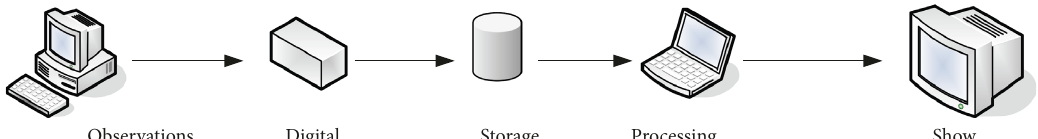
Figure 1: Framework diagram of digital image